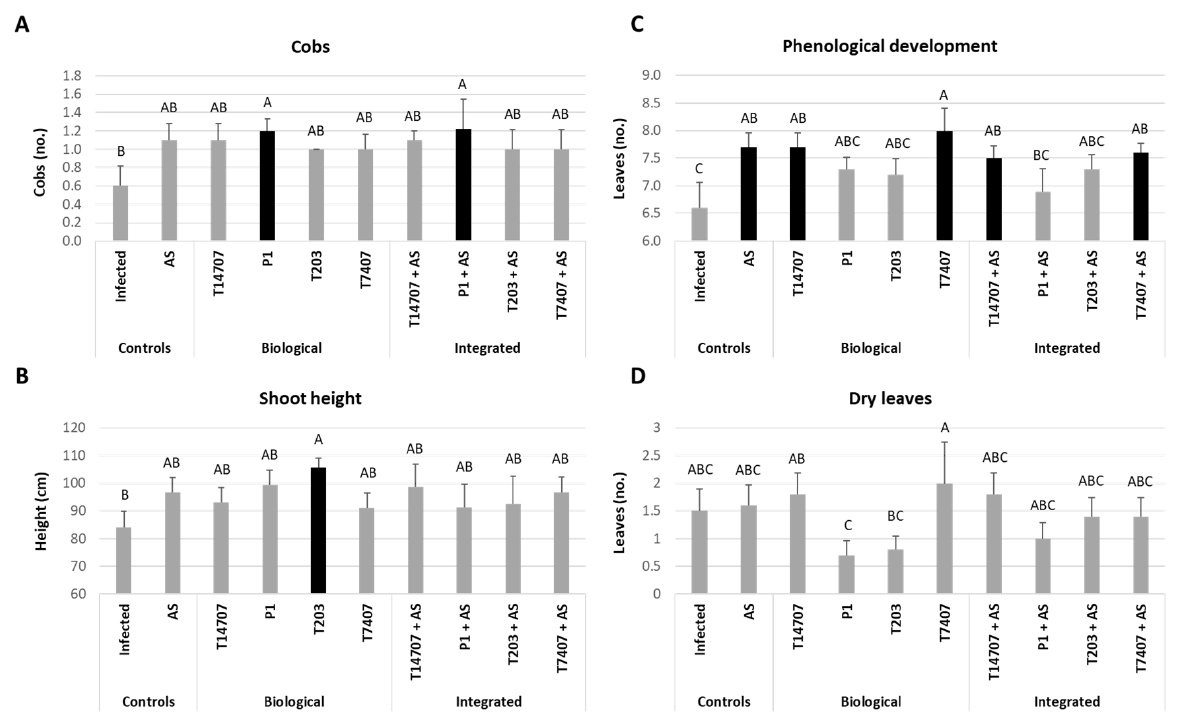
Figure 8. The open-enclosure trial growth parameters at day 61 from sowing. The experiment is described in Figure 6. The estimation included number of cobs ( A ), shoot height of the plants ( B ), phenological development (total number of leaves) ( C ) and number of dry leaves ( D ). Each value is a mean of 9–10 repetitions (plants per treatment). Error bars indicate standard error. Different letters above the chart’s bars (A–C) represent an ANOVA test significant difference ( p < 0.05).